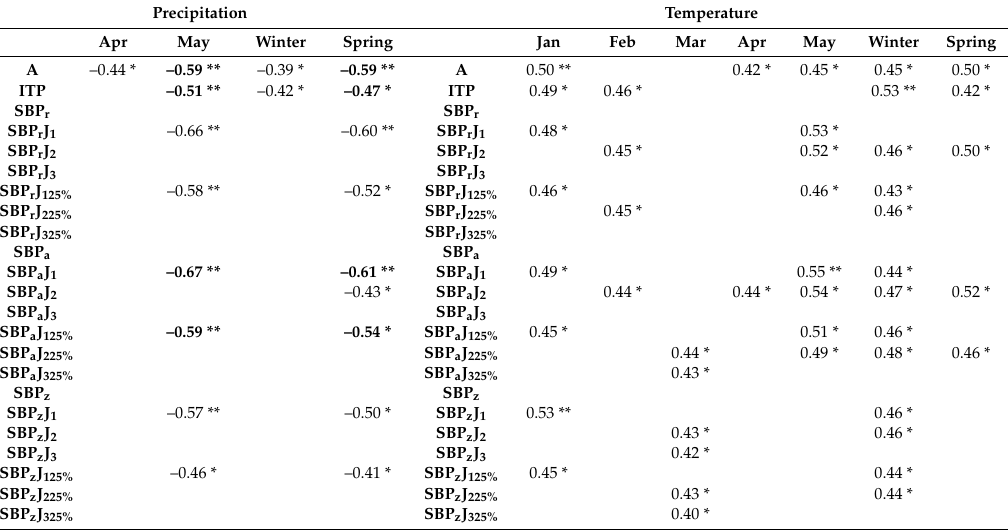
Table 2. Significant climate- δ 18 O correlation of various chronologies during current